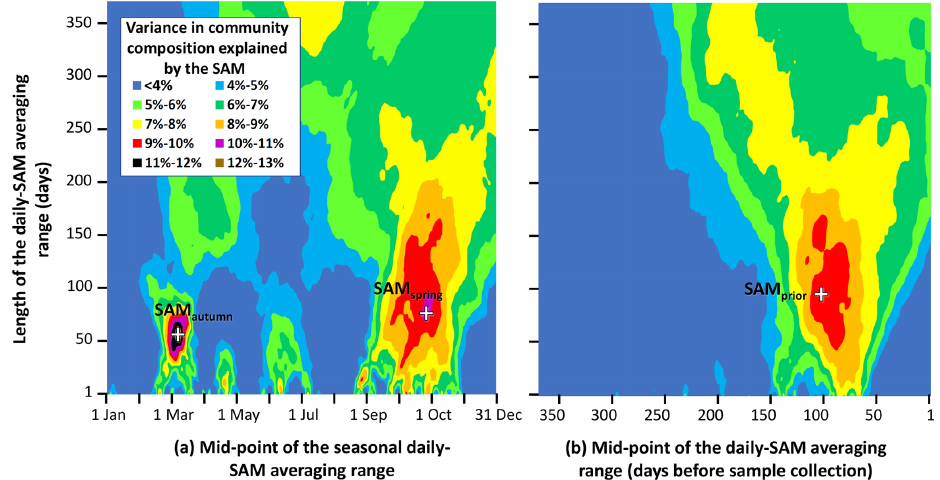
Figure 3. Variance in phytoplankton community composition explained by the SAM, versus timing and length of the averaged range of daily SAM values. Response surfaces relate the fraction of total variance in phytoplankton community composition attributable to the SAM, versus the number of days in the range of the averaged daily SAM (vertical axis) and the timing of the centre of the range of the averaged daily SAM (horizontal axis). The horizontal axis is expressed as (a) the time through the calendar year of the middle of the range, and (b) the number of days before a sample was collected, to the middle of the range. Three obvious maxima are identified with crosses (SAM autumn , SAM spring , and SAM prior